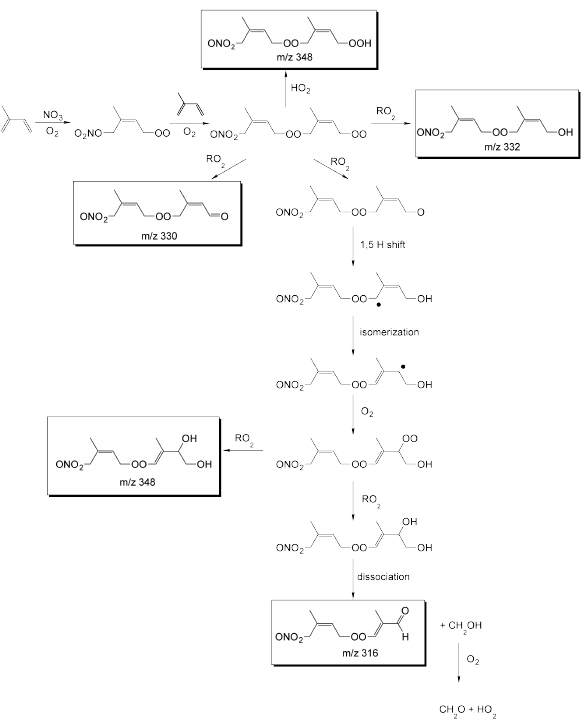
Fig. 8. Proposed formation mechanisms of products detected by CIMS at m/z 316, 330, 332, and 348. Other isomers are possible.